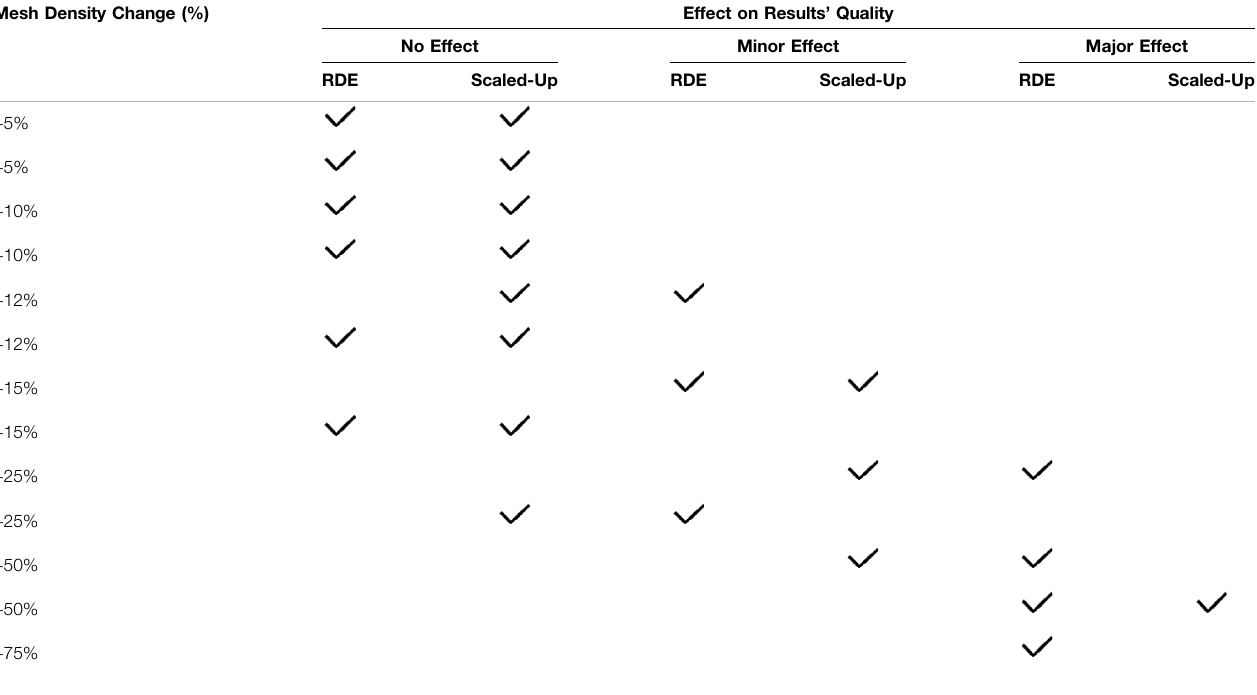
TABLE 3 | Comprehensive presentation of the effect of various changes in mesh ’ s density on the thickness pro fi les for both the RDE and industrial-scale models. Mesh Density Change